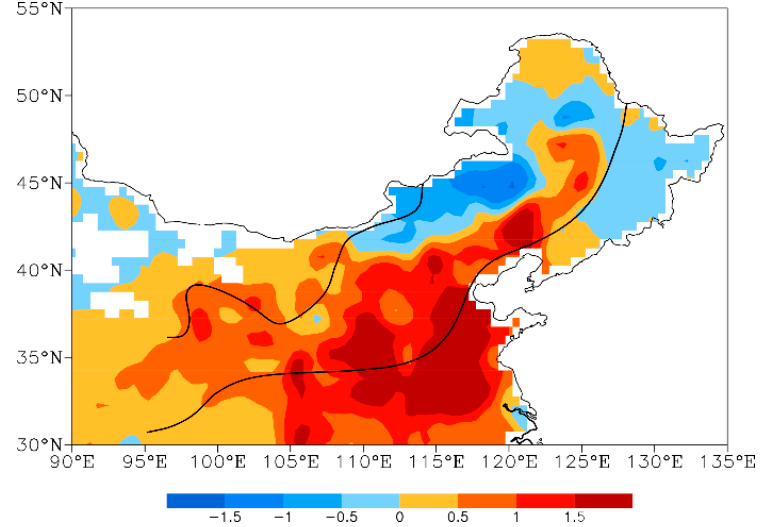
Figure 3. The spatial pattern of summer ET trend (mm/year) in NDPB in China.